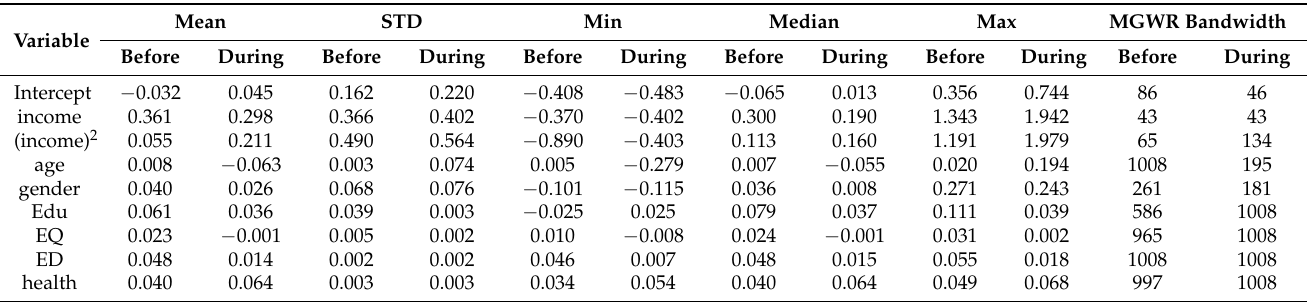
Table 7. Summary statistics for MGWR parameter estimates and